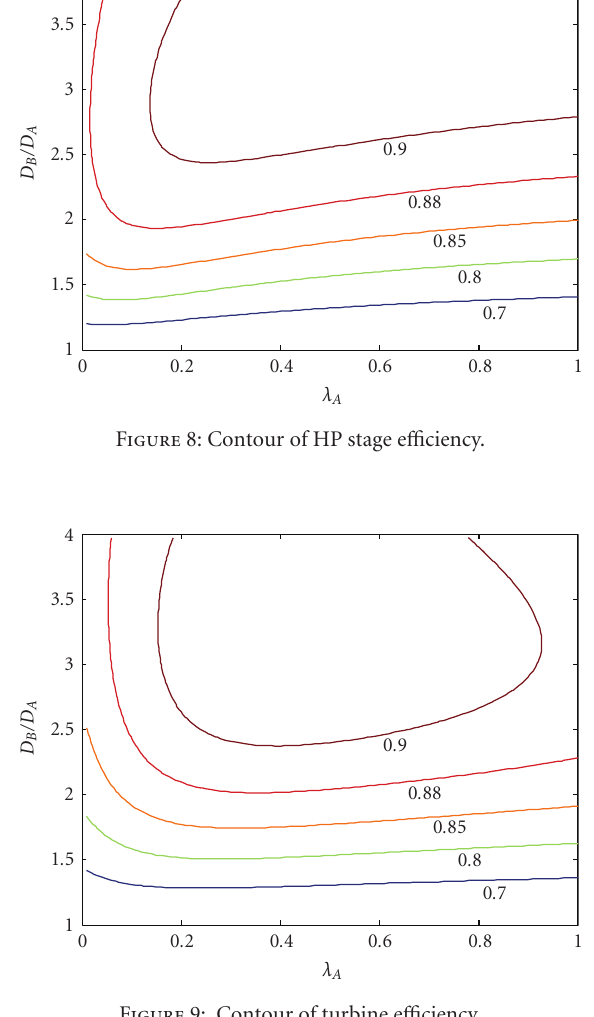
Figure 9: Contour of turbine e ffi